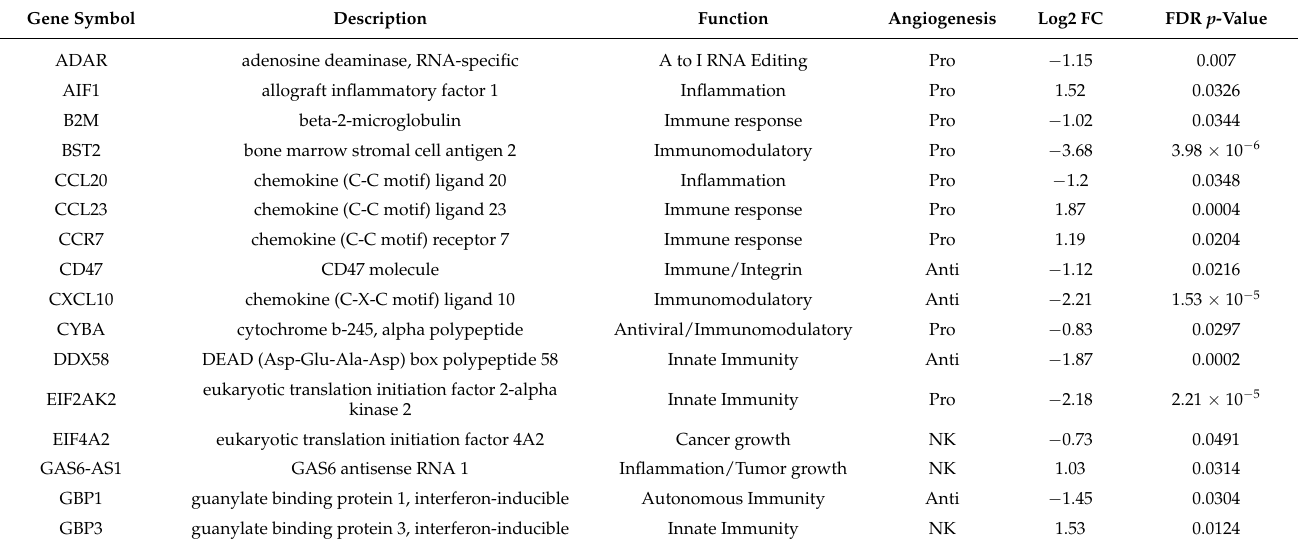
Table 4. List of genes involved in the enriched pathways and their potential